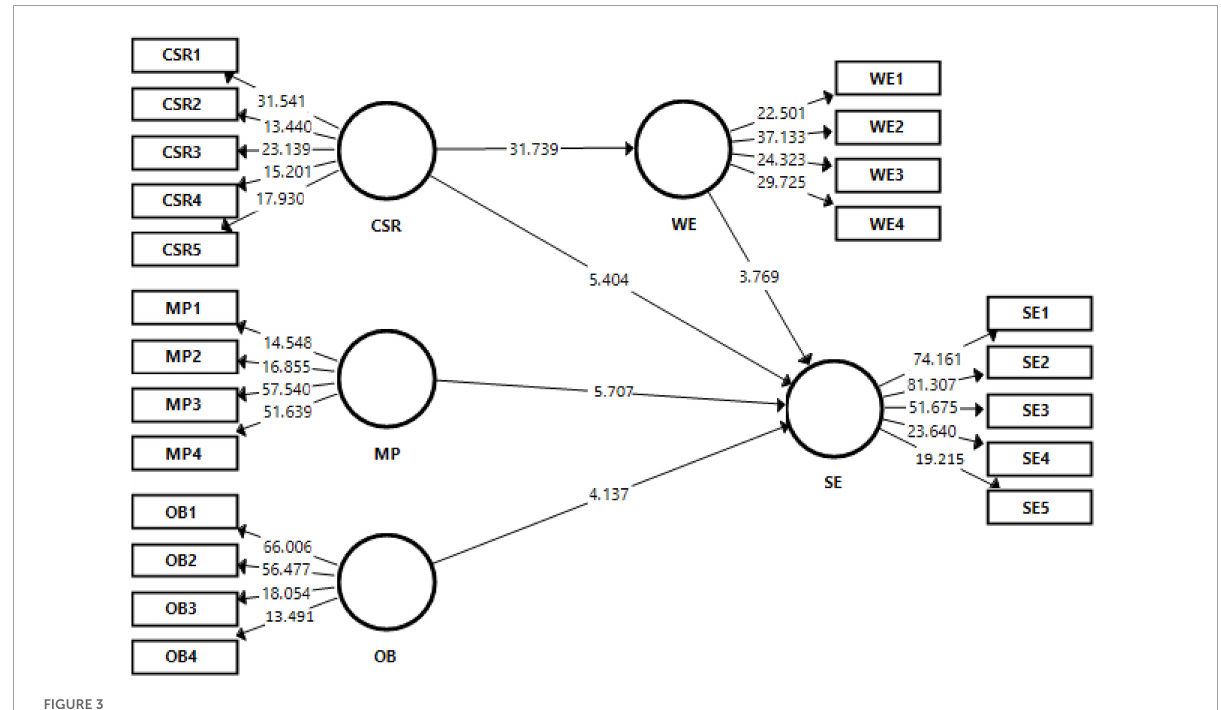
FIGURE3 Structural